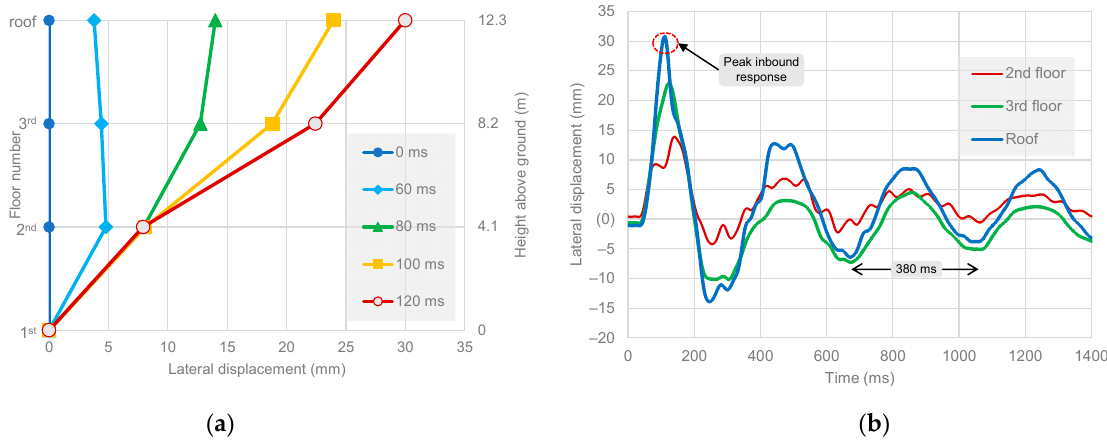
Figure 14. Test 1—Lateral response of structure: ( a ) Deflected shape at different times; ( b ) Lateral deflection history and estimation of natural period, data from DG4, DG5, and DG6.